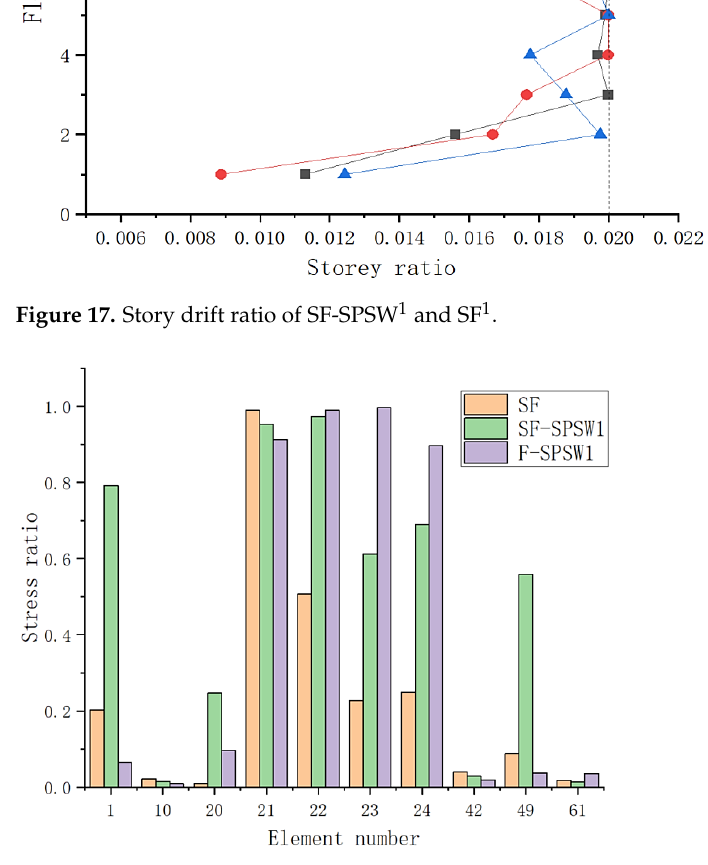
Figure 18. Stress ratio of SF-SPSW 1 and SF 1